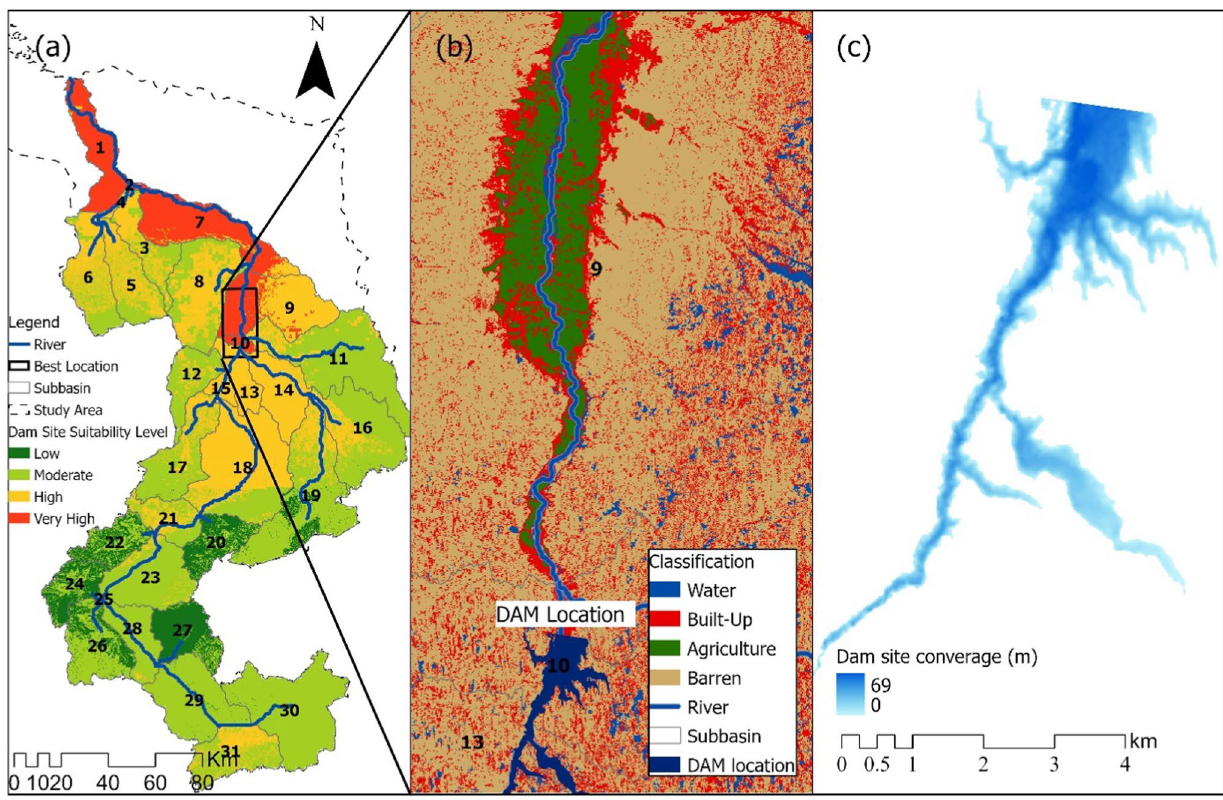
Fig. 4 Dam site suitability map using AHP: a dam site suitability level map on the subbasins level, b land-use–land-cover map created using Landsat 8 satellite images using support vector machine, c spatial extension of water in case of dam construction in subbasin